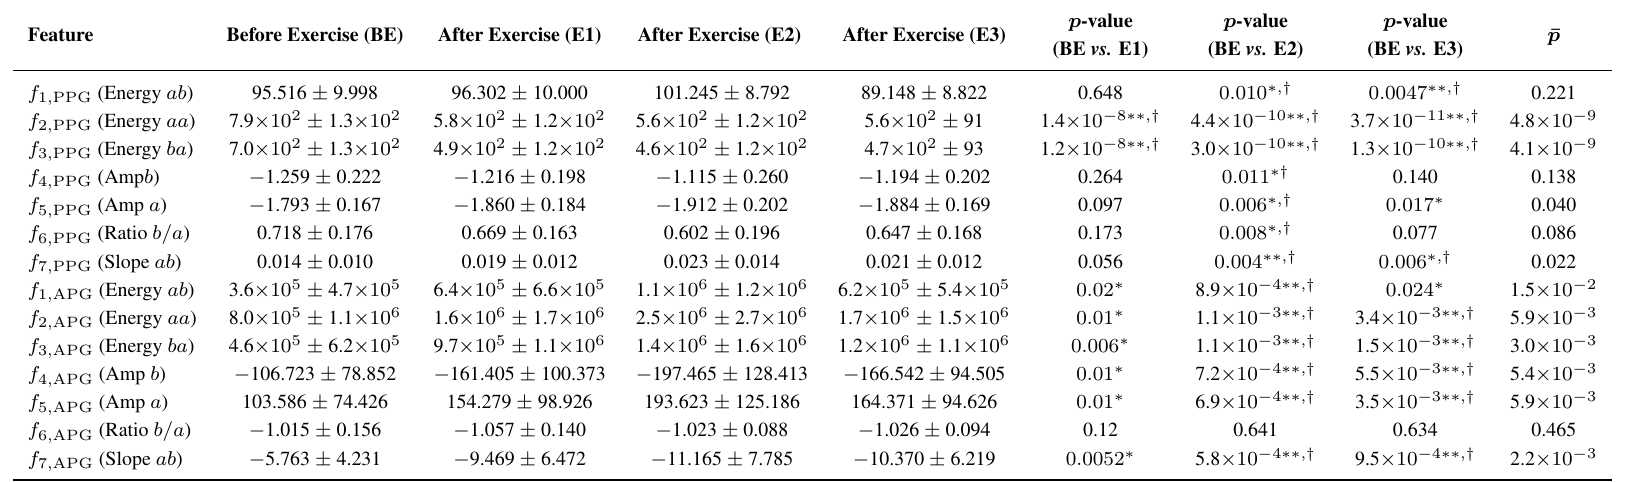
Table 2. Feature comparison in differentiating between before and after exercise measurements. Mean and standard deviation values of 14 features extracted from the PPG and APG waveforms. The p -value of discriminating between before exercise (BE) and after three exercises (E1, E2 and E3) is calculated using the Mann–Whitney test. The average of the three p -values ( ¯ p ) is given in the last column. Uncorrected p -values from the Mann–Whitney test, where * and ** indicate p < 0 . 05 and p < 0 . 005 , respectively; † indicates p values that remain significant with a p < 0 . 05 after post-correction (Bonferroni–Holm, α < 0 . 05